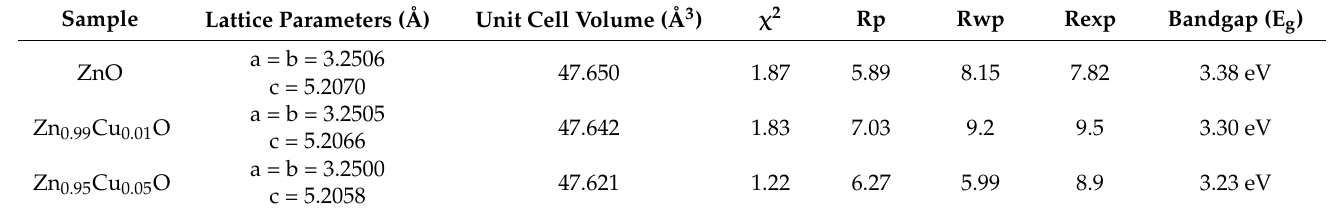
Table 1. Various structural parameters obtained from the Rietveld refinement and bandgap energy of Cu-doped ZnO nanostructures.